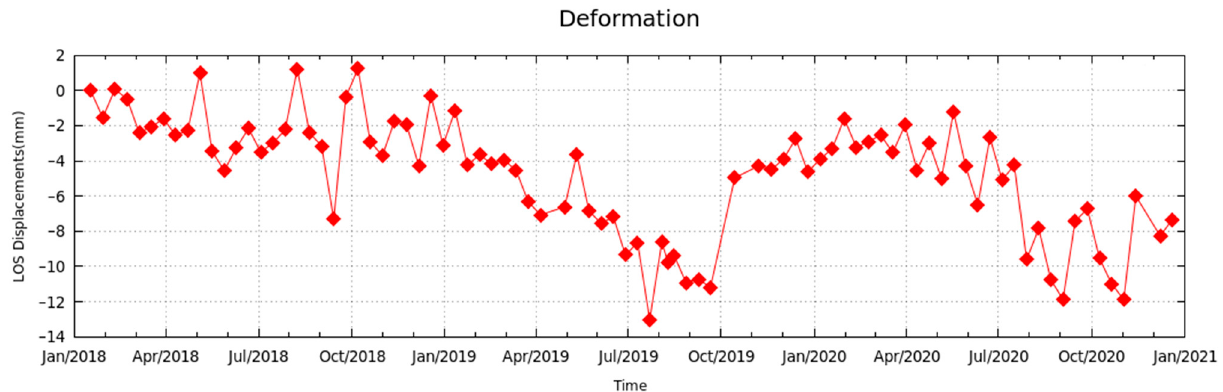
Figure 14. Deformation of point P4 during the monitoring period.